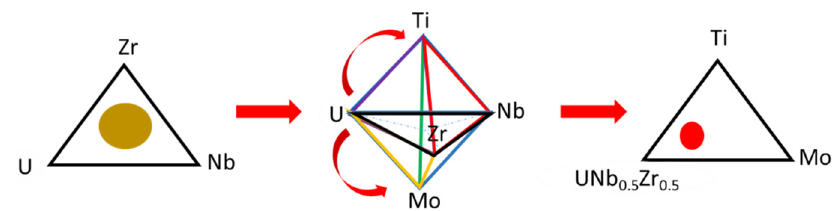
Figure 13. Design process of a DUHEA.